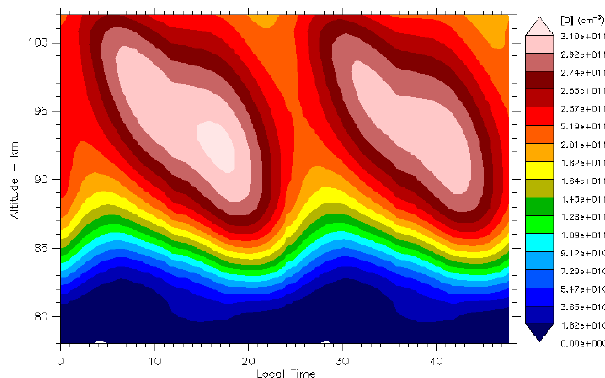
Fig. 2b. Model H for model days seven through eight for August at the Equator. Note the scale is 1.12 times larger than in Fig. 2a. From 85 to 90km the April H values are approximately two-thirds the August values.